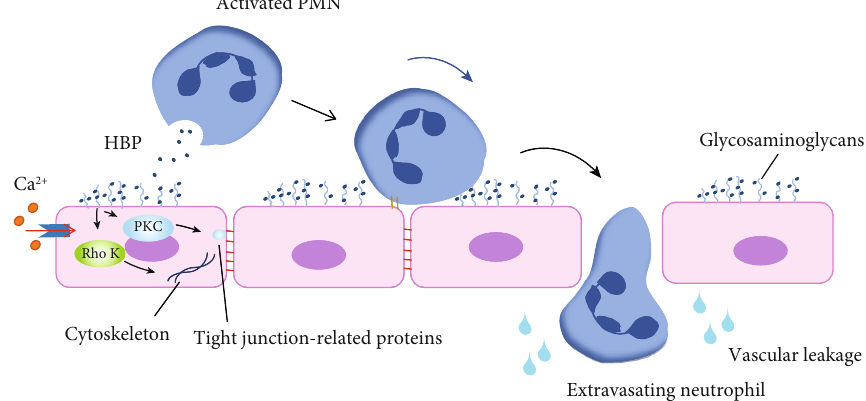
Figure 2: HBP induces increased endothelial permeability that eventually results in vascular leakage. PMNs bind ECs to release HBP, and then HBP interacts with ECs through glycosaminoglycans. Once HBP is internalized via a receptor-mediated process, PKC and Rho kinase are activated, ultimately leading the rearrangement of the cytoskeleton and cell contraction. PKC also phosphorylates tight junction-related proteins to facilitate changes in the tight junctions between ECs. As a result, gaps form between ECs that ultimately result in vascular leakage.